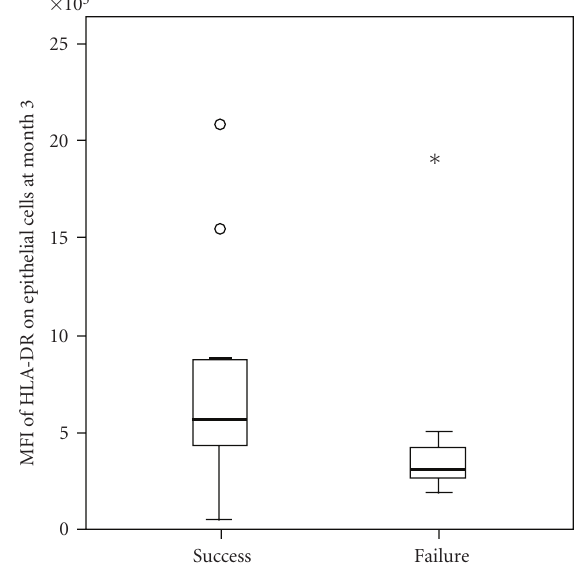
Figure 1: Box plot of expression of HLA-DR on conjunctival epithelial cells (MFI-mean fluorescence intensity) collected by impression cytology 1 month after surgery in eyes with surgical success and failure at 6 months ( P = . 036). The boundaries of each box indicate the 25th and 75th percentiles, the whiskers indicate the minimum and maximum values, and the line within each box indicates the median.